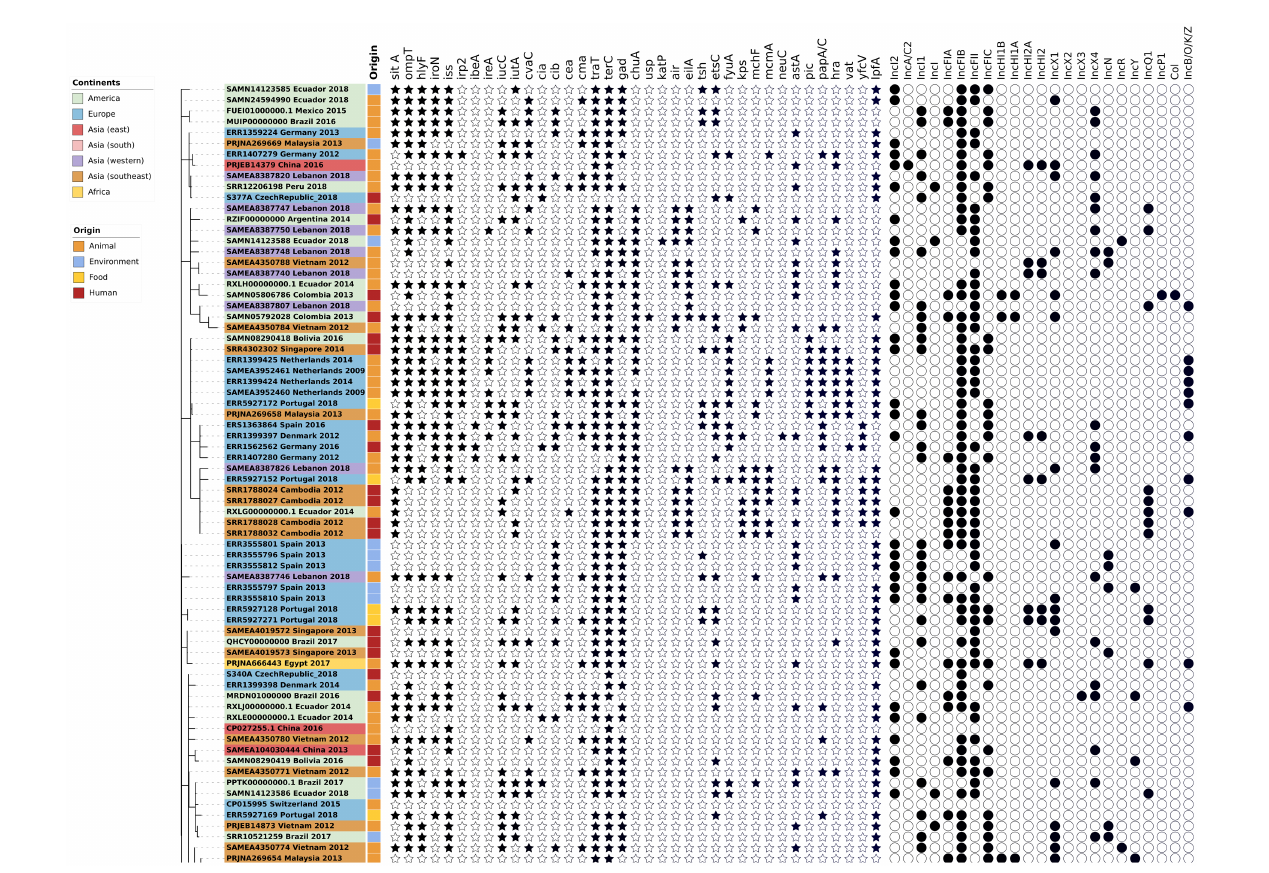
FIGURE 2 Virulence genes and plasmid content of the evaluated E. coli sequences (Part one). The source of the isolates is specified by different colors in the genomic cg-MLST tree branches. The presence and absence of virulence genes and plasmid incompatibility groups are indicated by star and circle symbols,